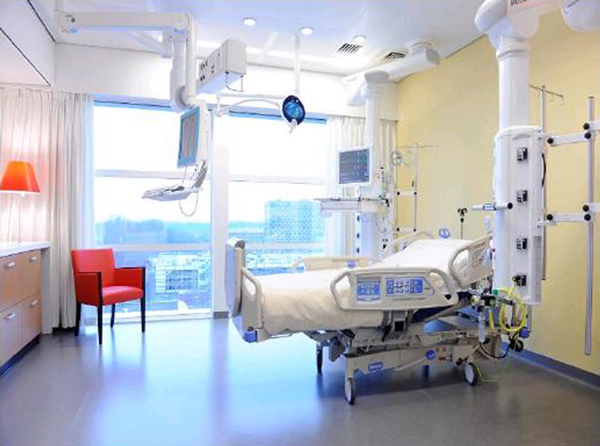
New, single-room ICU.